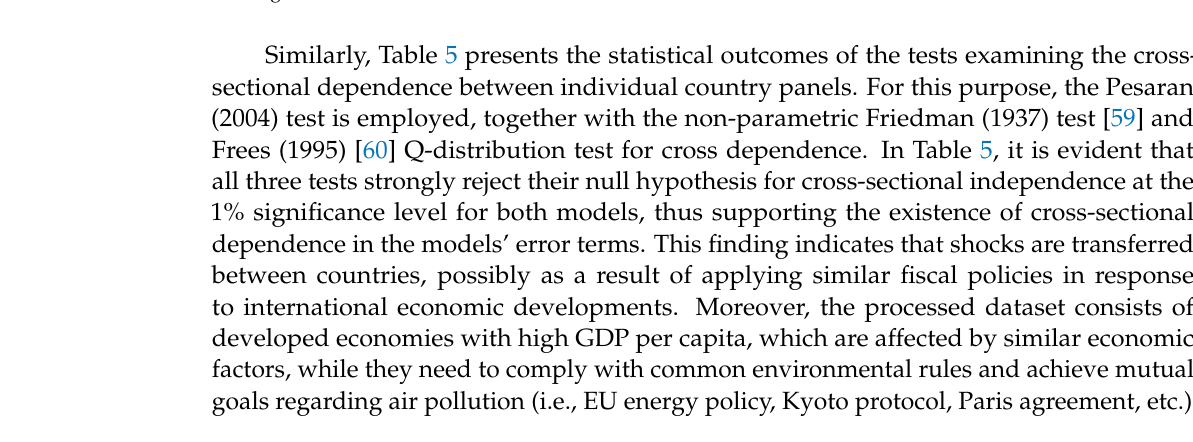
Table 5. Cross-Section dependence among